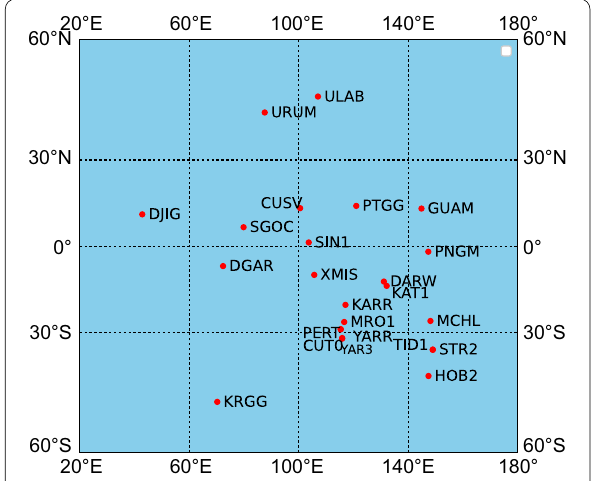
Fig. 9 Station distribution for PPP users with GPS, Galileo, and BDS-2